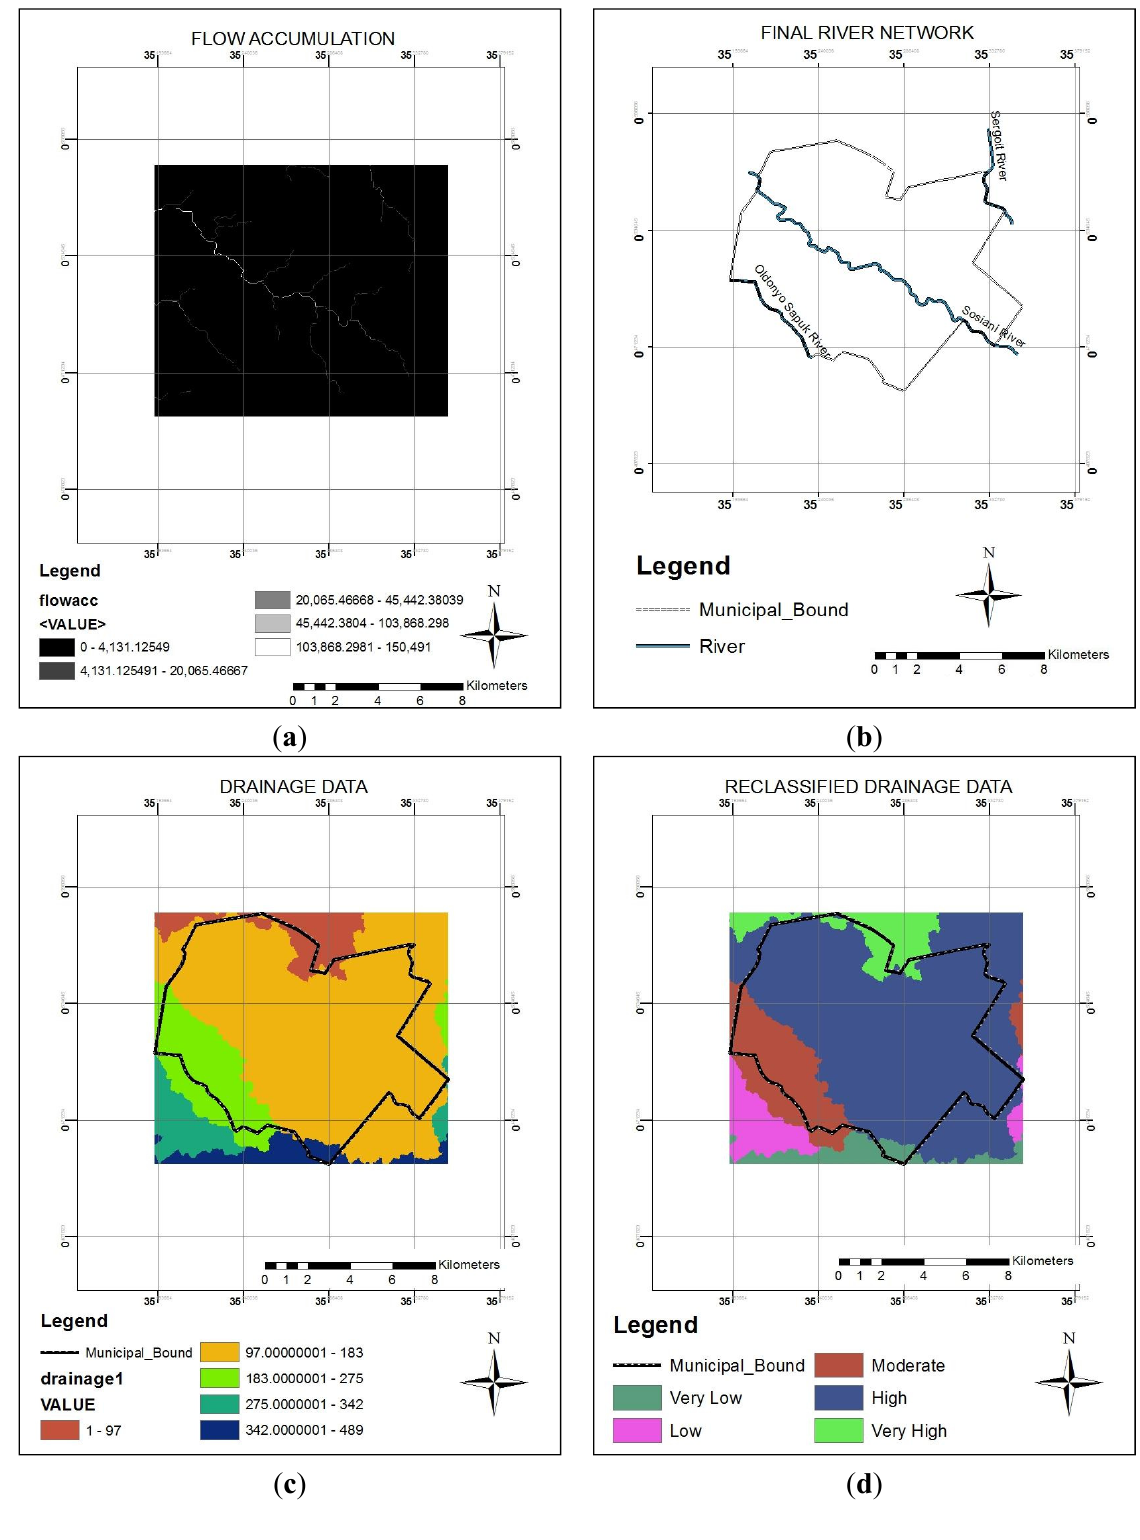
Figure 11. Drainage network depicting: ( a ) flow accumulation; ( b ) main rivers derived from the flow accumulation thresholding; ( c ) drainage density and ( d ) reclassified drainage density